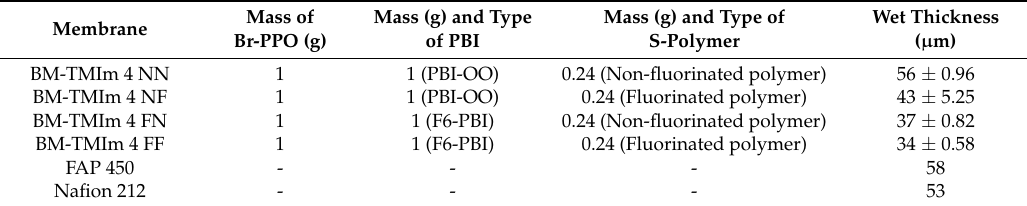
Table 1. Membranes preparation